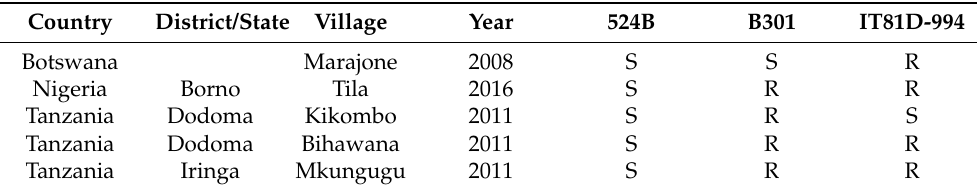
524B: Blackeye type A. vogelii susceptible cowpea breeding line; B301: Cowpea landrace collected from Botswana with known A. vogellii Stiga gesnerioides resistance; IT81D-994: Cowpea line developed by the International Institute of Tropical Agriculture with known resistance to A. vogelii and S. gesnerioides ; R = Resistant; S =